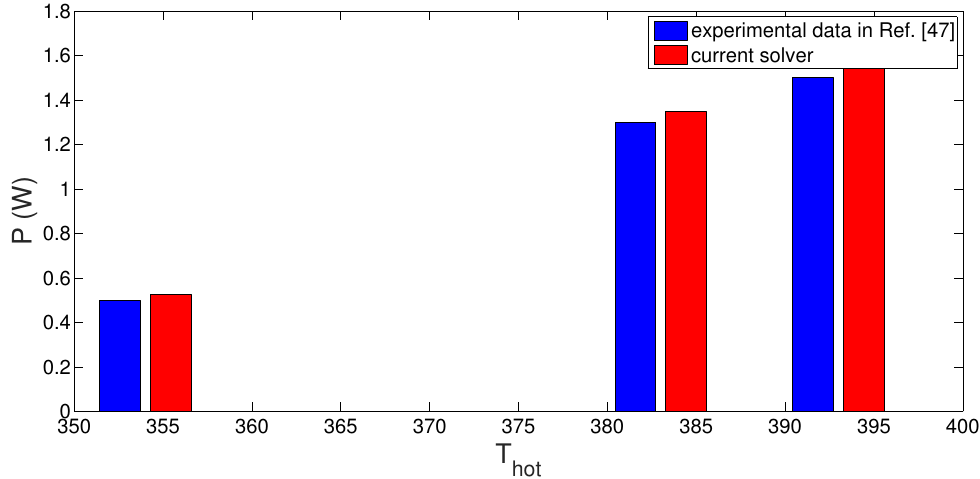
Figure 4. Comparison of generated TEG power with the present code and available results in Ref.